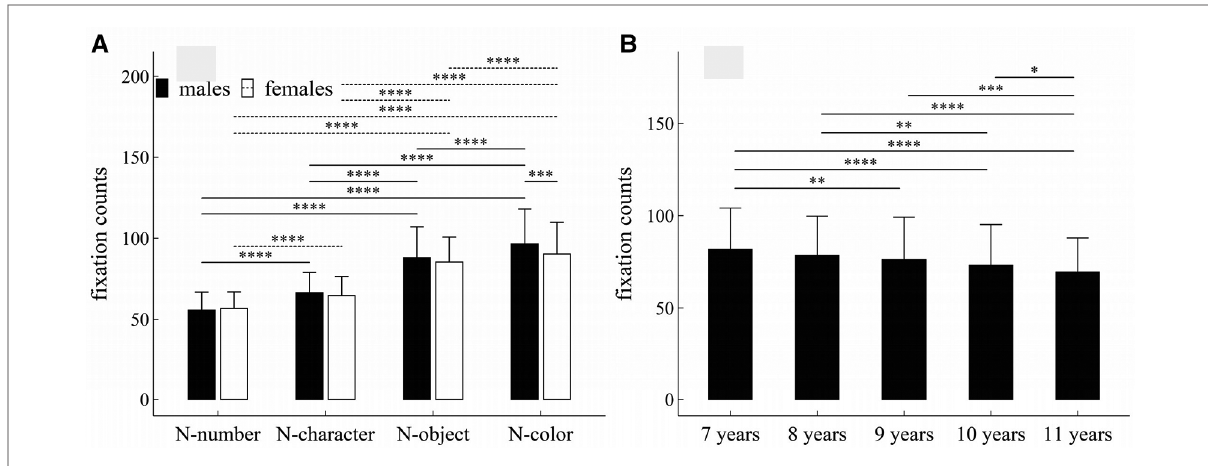
FIGURE 1 In fl uence of task-type, gender and age on fi xation counts: ( A ) interactive effect of gender and task-type; ( B ) in fl uence of age. * p <0.05; ** p <0.01; *** p <0.001; **** p <1×10 − 4 .